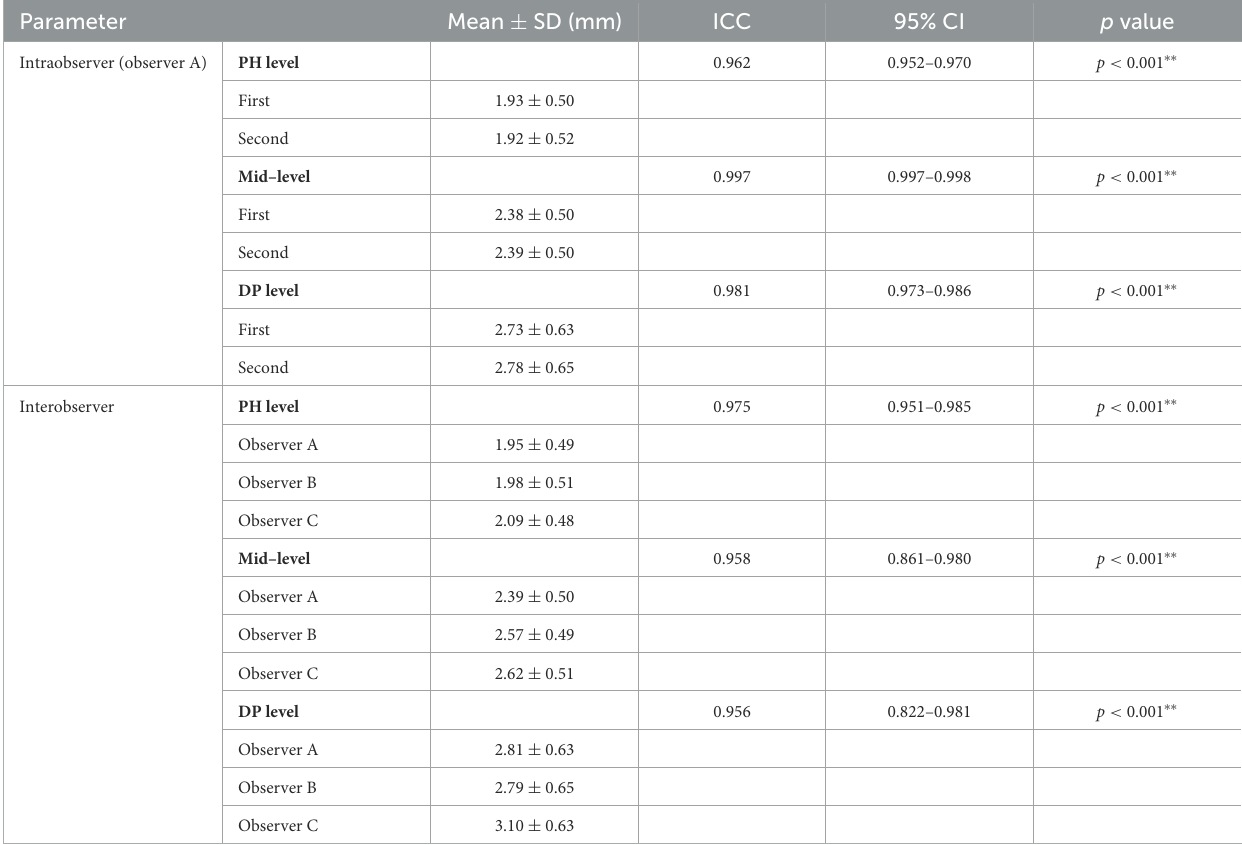
TABLE 3 Intraobserver and interobserver reliability for the CBD diameter at PH and DP level using ICC and their 95% CI.